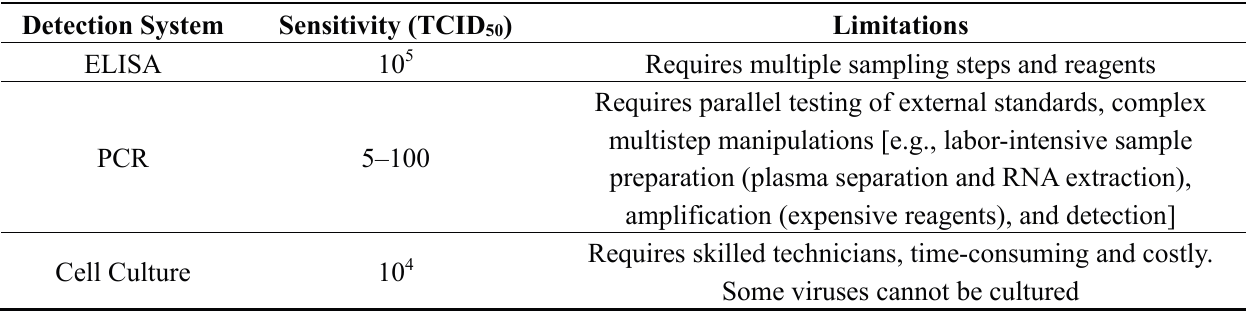
Table 1. Comparison of sensitivity and limitations of conventional viral detection